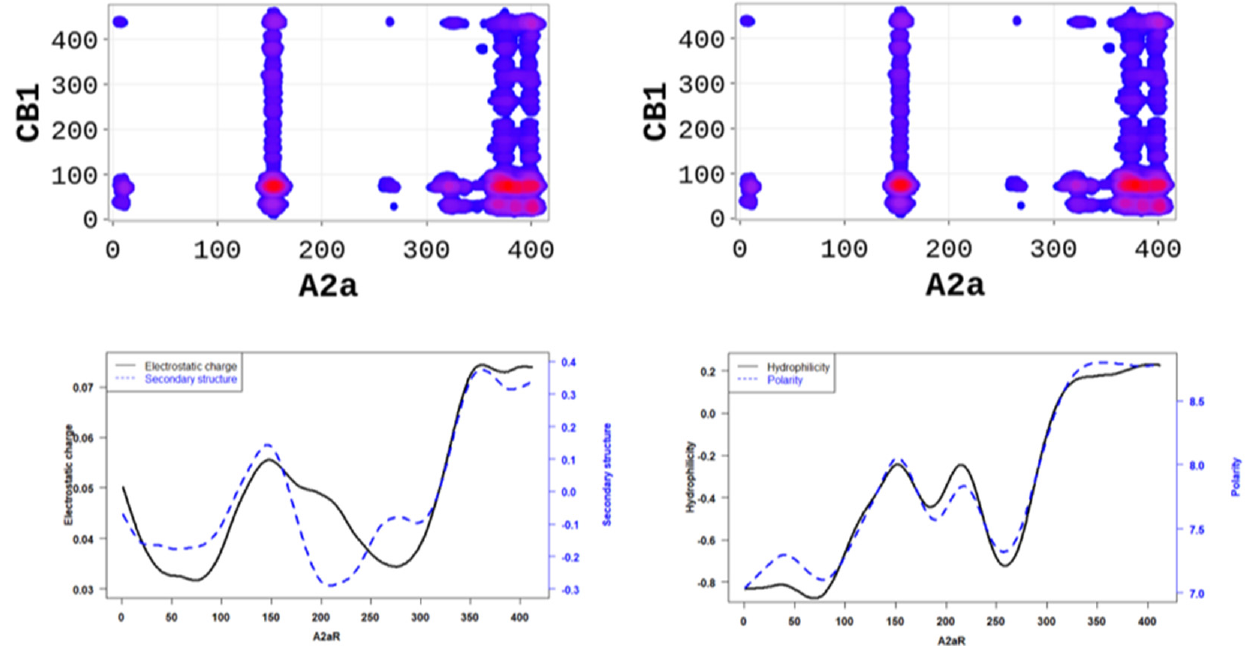
Figure 3. A2aR/CB1R dimerization is driven by the polarity of A2aR and its hydrophilicity. On av- erage, polarity and hydrophilicity (left panel) of amino-acids are higher at the predicted hot-spots. Additionally, on average, electrostatic charges (right panel) of these amino-acids are higher at the predicted hot-spots and their secondary structures are dominated by alpha-helix conformation